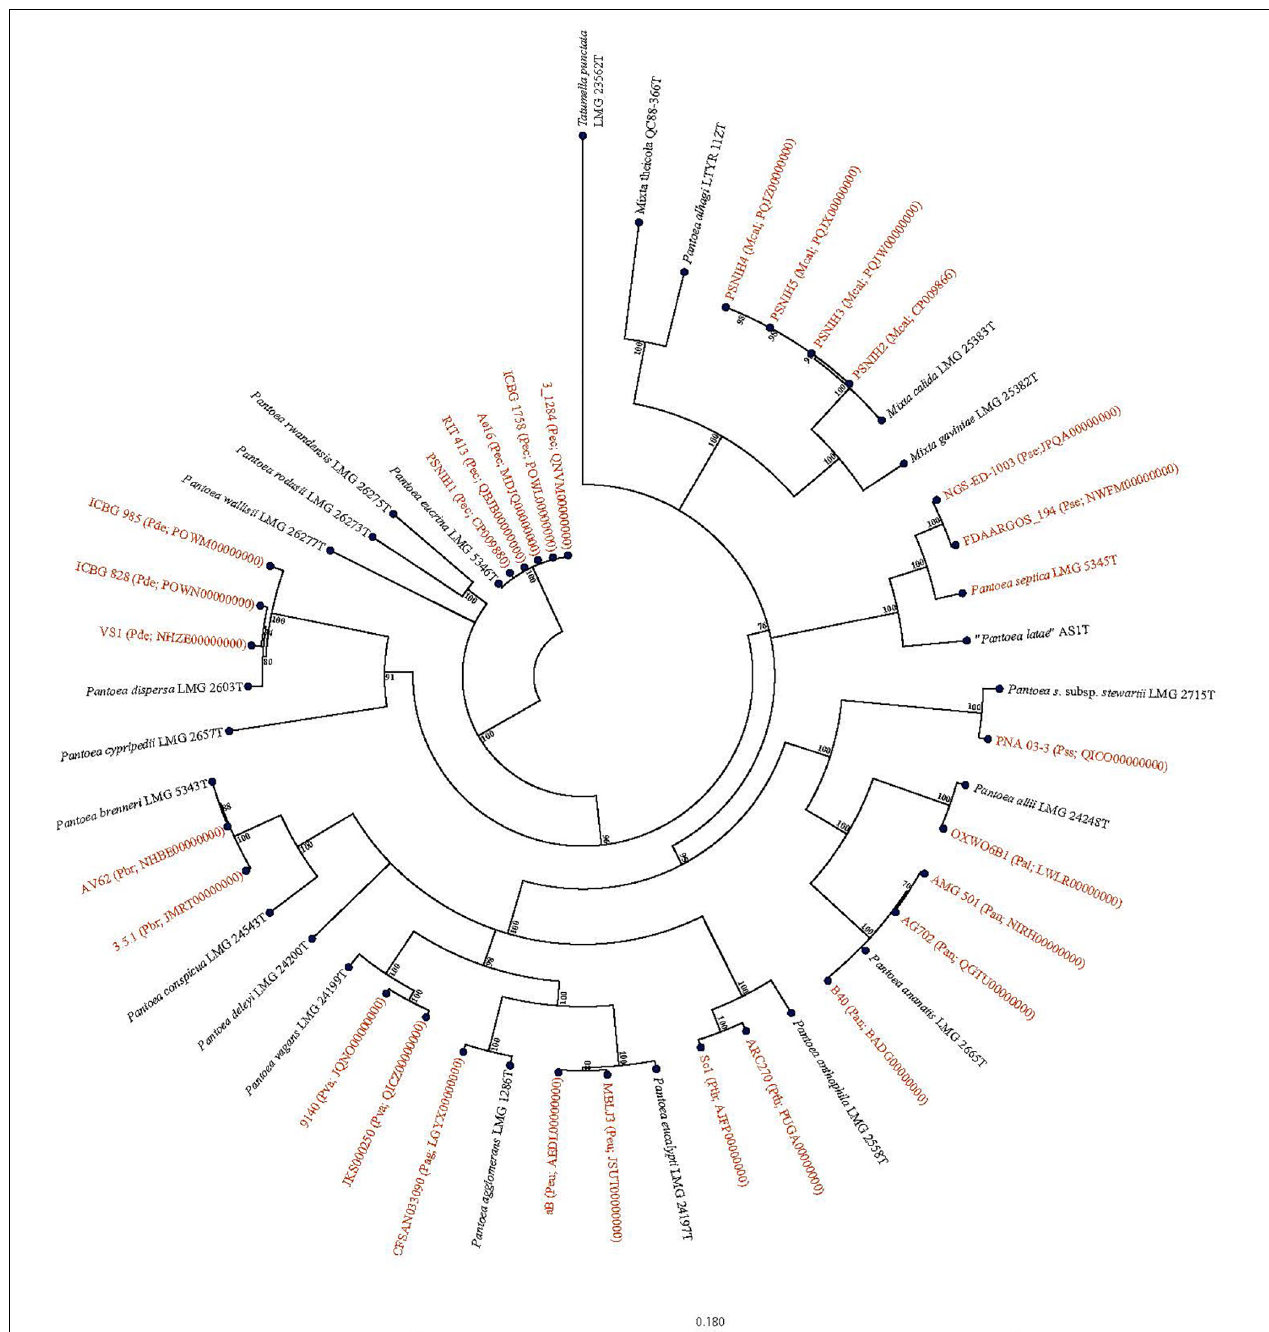
FIGURE 3 | Maximum Likelihood phylogenetic tree of five concatenated genes of 29 complete and draft genomes previously reported as Pantoea Mixta sp. showing species level taxonomic affiliations to validly described type strains of Pantoea and Mixta species. The type strain of Pantoea , and Mixta species associated with a given Pantoea sp. genome entry based on the collective data of the six parameters ( leu S, MLSA, gDDH, ANI, ANIm, and TETRA) recorded is given in brackets before the NCBI genome accession number: Pag, P. agglomerans ; Pal, P. allii ; Pan, P. ananatis ; Pth, P. anthophila ; Pbr, P. brenneri ; Pde, P. dispersa ; Peu, P. eucalypti ; Pec, P. eucrina ; Pse, P. septica ; Pss, P. stewartii subsp. stewartii ; aPva, P. vagans; Mcal; Mixta calida . Pantoea , Mixta, and Tatumella type strains are in